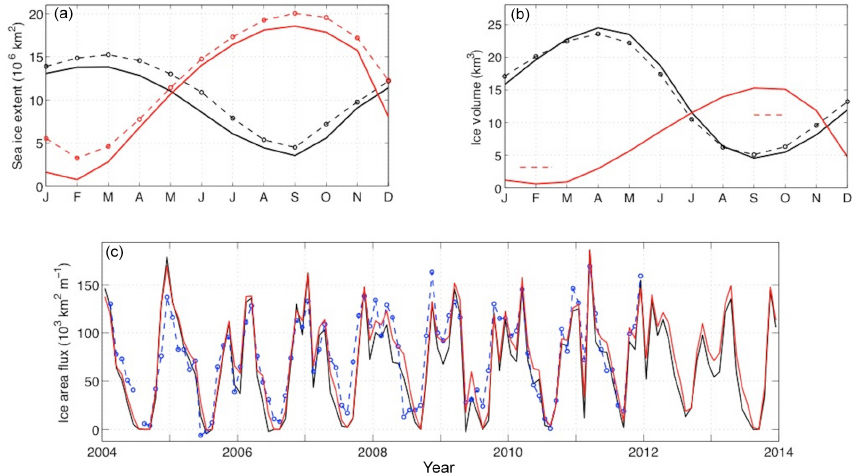
Figure 8. (a) Mean GLOB16 seasonal cycles of sea ice extent (10 6 km 2 ) for the Arctic (black) and Antarctic (red) oceans compared to satellite observations (dashed line) provided by NSIDC. Sea ice extent is defined as the area enclosed in the 10% sea ice concentration contour. (b) Mean seasonal cycles of sea ice volume (10 3 km 3 ) for the Arctic Ocean (black) compared to PIOMAS reanalysis (dashed line) and for the Antarctica (red) compared to minimum and maximum values from ICESat. (c) Sea ice area export (10 3 km 2 month − 1 ) across Fram Strait for GLOB16 (red), GLOB4 (black), and observations